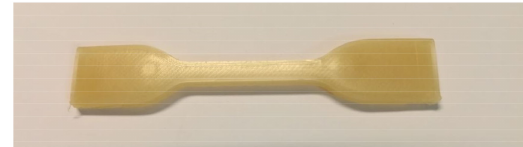
Figure 8. 3D printed dogbone for tensile tests (PHB/PLA/A-4).